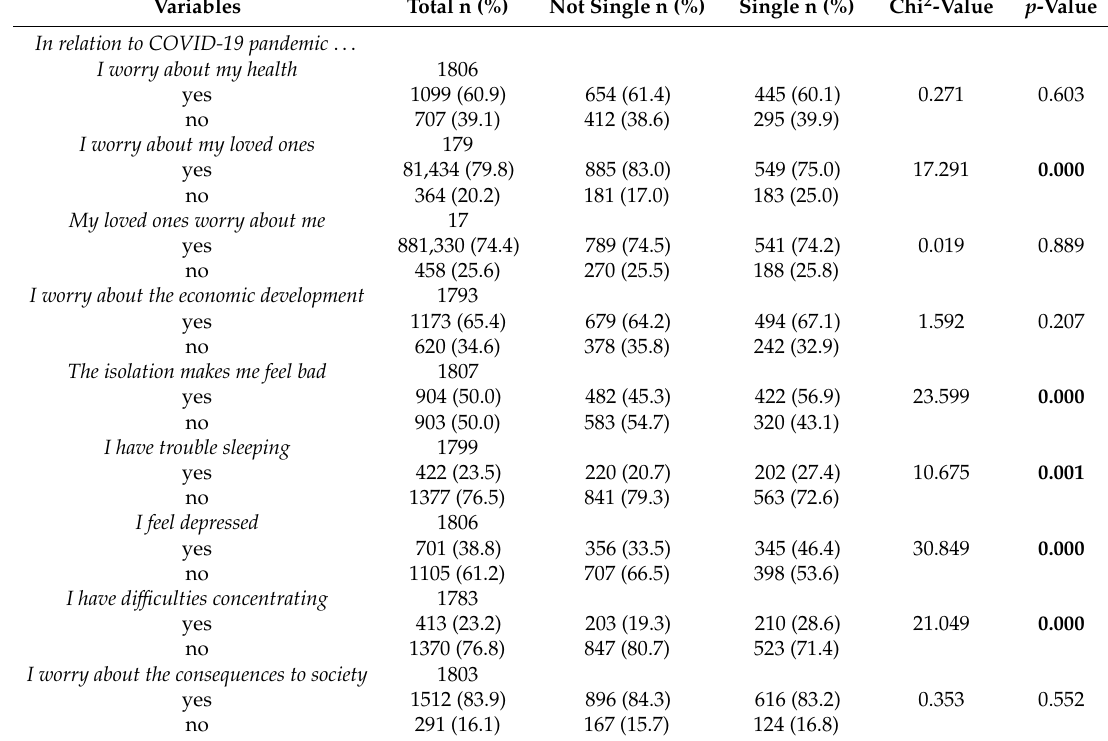
Table 5. Self-reported mental health based on civil status (number, percentage and Chi 2 -analysis). Variables Total n (%) Not Single n (%) Single n (%) Chi 2 -Value p